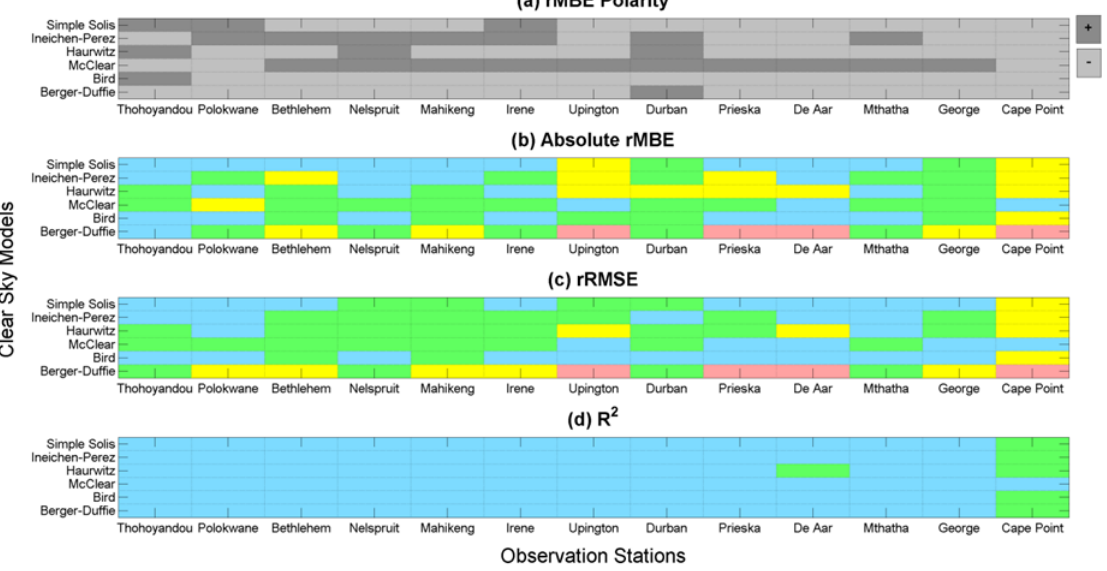
Figure 9. Overall performance of the six models at the 13 stations.